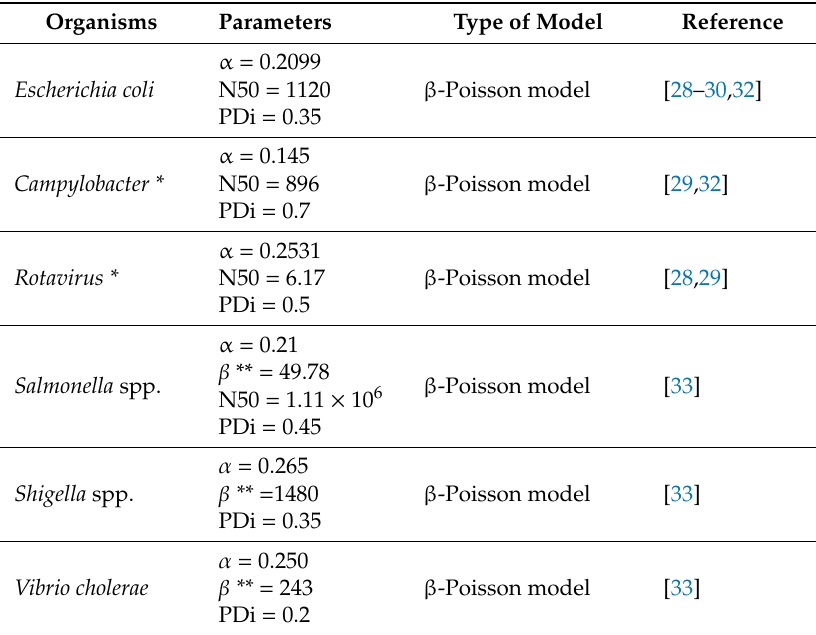
Table 2. Dose–response